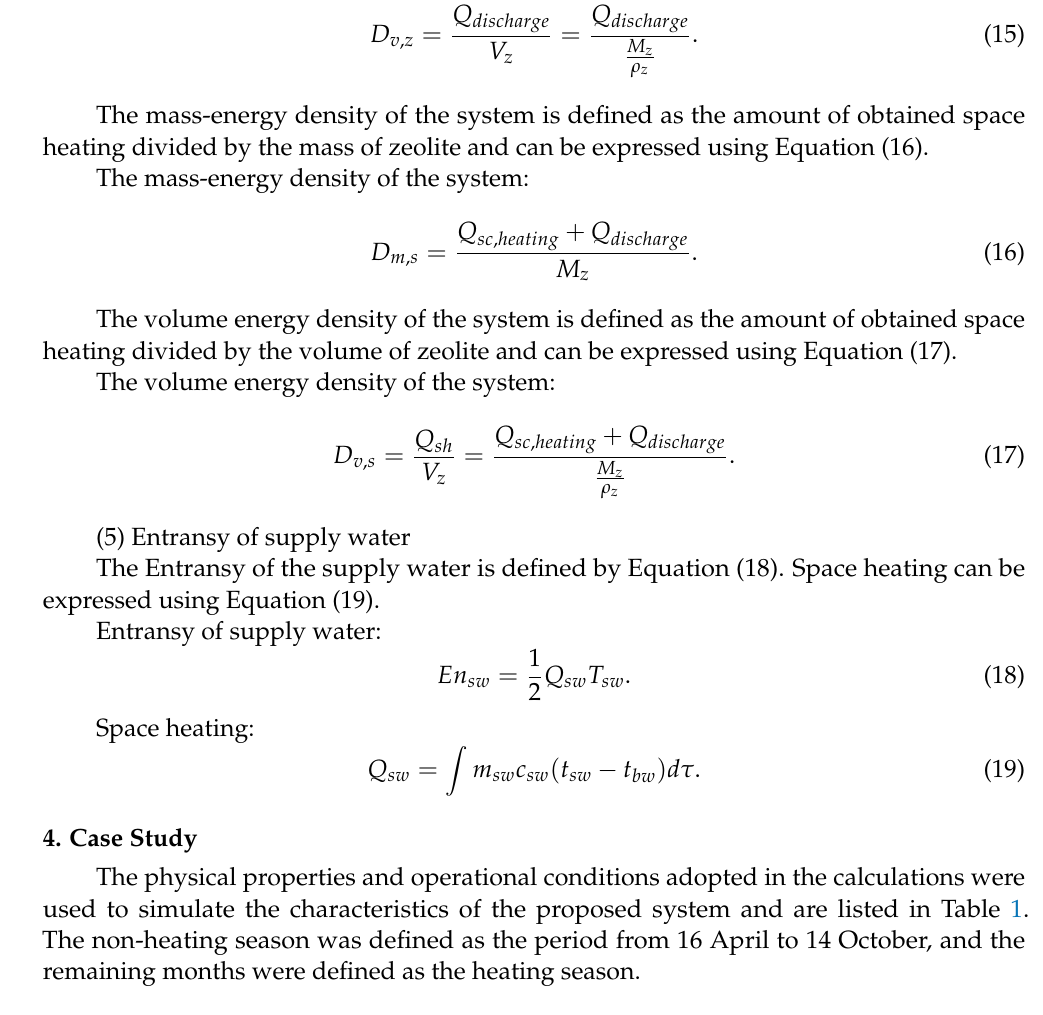
Table 1. Physical properties and operational conditions of the proposed